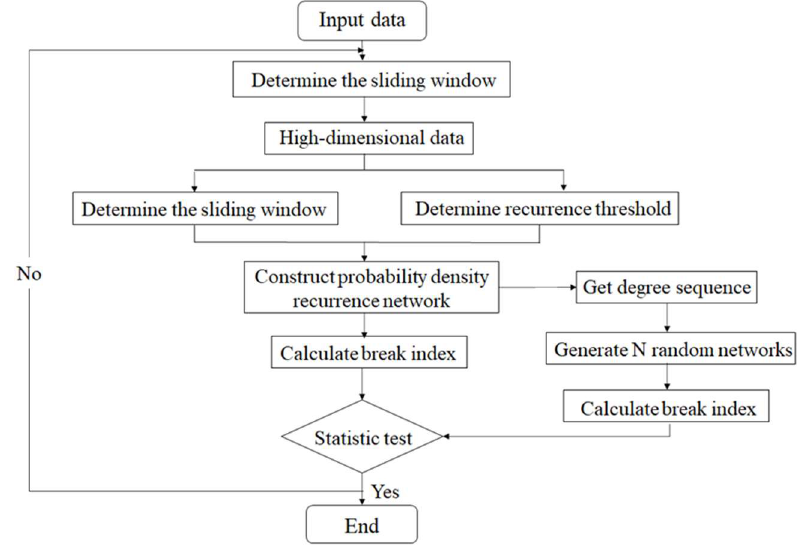
Figure 1. Algorithm flowchart.